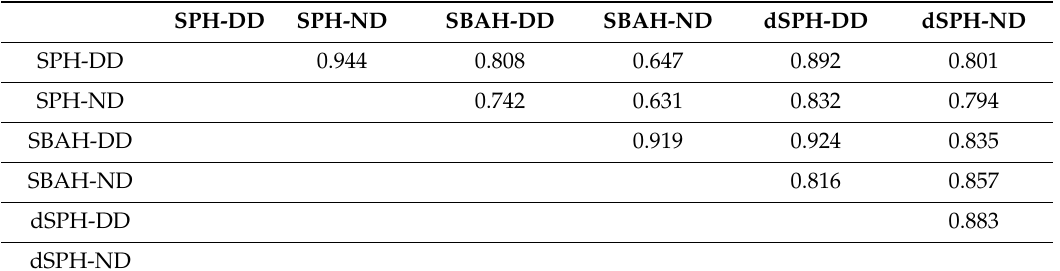
Table 4. Spatial correlations between water ecosystem service SPH, SBAH, and dSPH according to perceptions of directly dependent (DD) and indirectly dependent (ID) stakeholders.